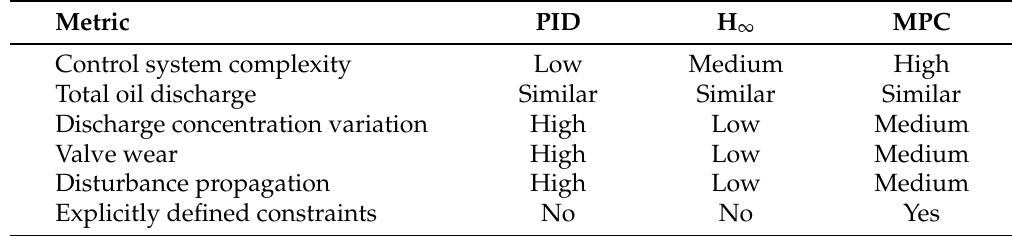
Table 2. Summarizing the relative performance metrics. Metric